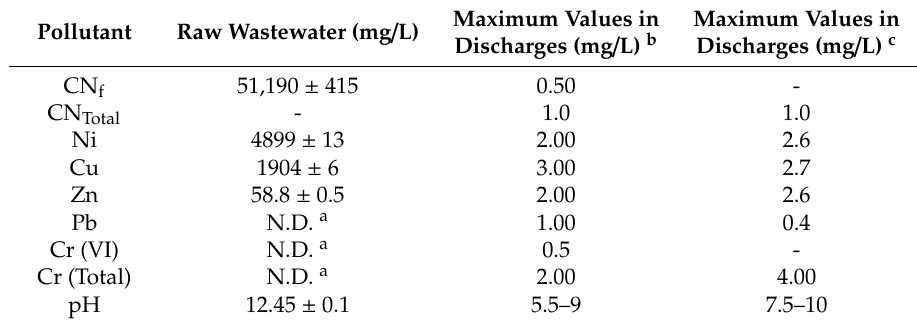
Table 1. Composition of the untreated wastewater studied, from an electroplating industry, and the maximum allowable values for limited discharges into the public wastewater treatment